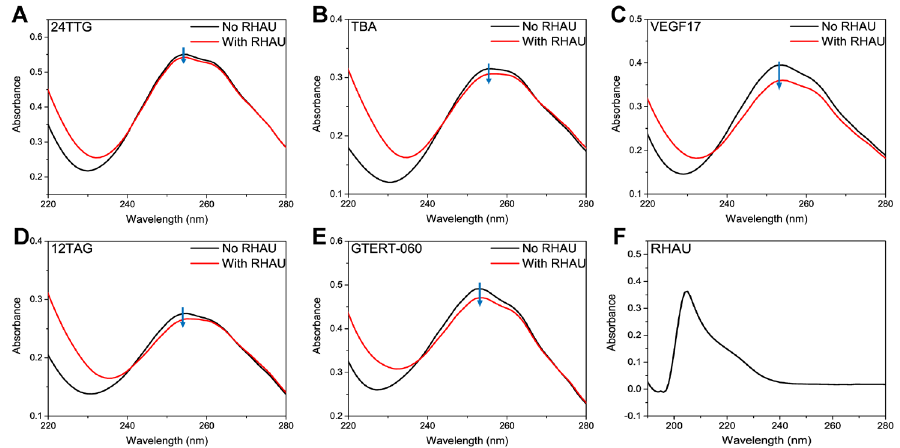
Figure 2. UV-Vis spectra of ( A ) 24TTG, ( B ) TBA, ( C ) VEGF17, ( D ) 12TAG and ( E ) GTERT-060 RHAU (black lines) and with RHAU (red lines) at the ratio of 1:2 (10 µ M G4s and 20 µ M RHAU) after without RHAU (black lines) and with RHAU (red lines) at the ratio of 1:2 (10 μM G4s and 20 μM RHAU) after 30 min incubation at room temperature. ( F ) UV-Vis spectrum of RHAU (20 μM) 30 min incubation at room temperature. ( F ) UV-Vis spectrum of RHAU (20 µ M) dissolved in water. dissolved in water. The blue arrows indicated the variation trend of UV-Vis signals from “No The blue arrows indicated the variation trend of UV-Vis signals from “No RHAU” to “With RHAU” to “With RHAU”.